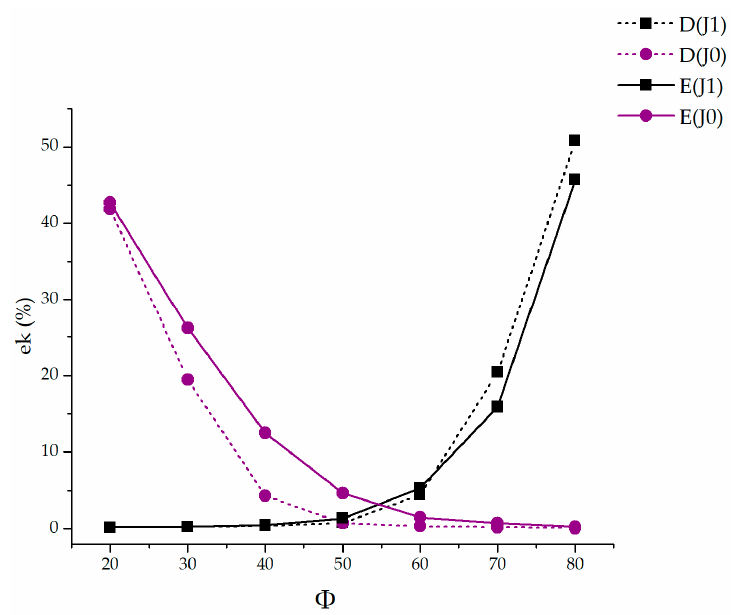
Figure 11. E ff ect of the superficial fraction on ek response for all Figure 11. Effect of the superficial fraction on ek response for all systems.